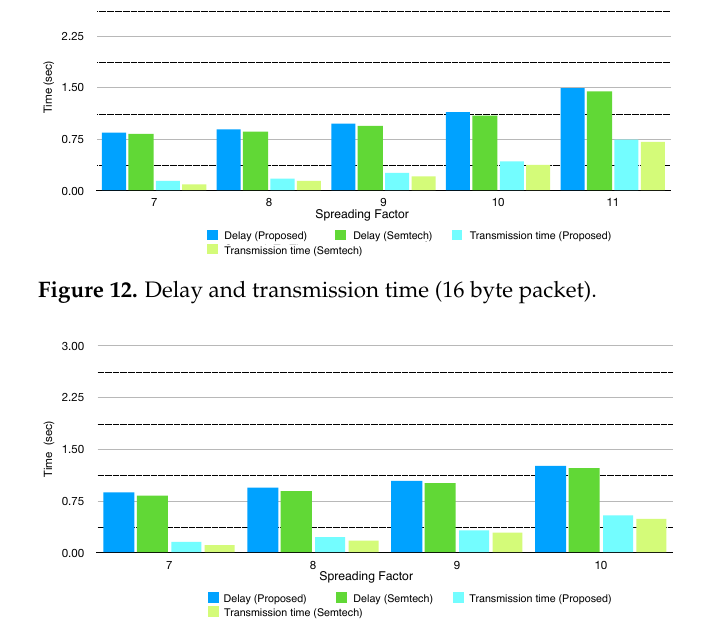
Figure 13. Delay and transmission time (32 byte packet).